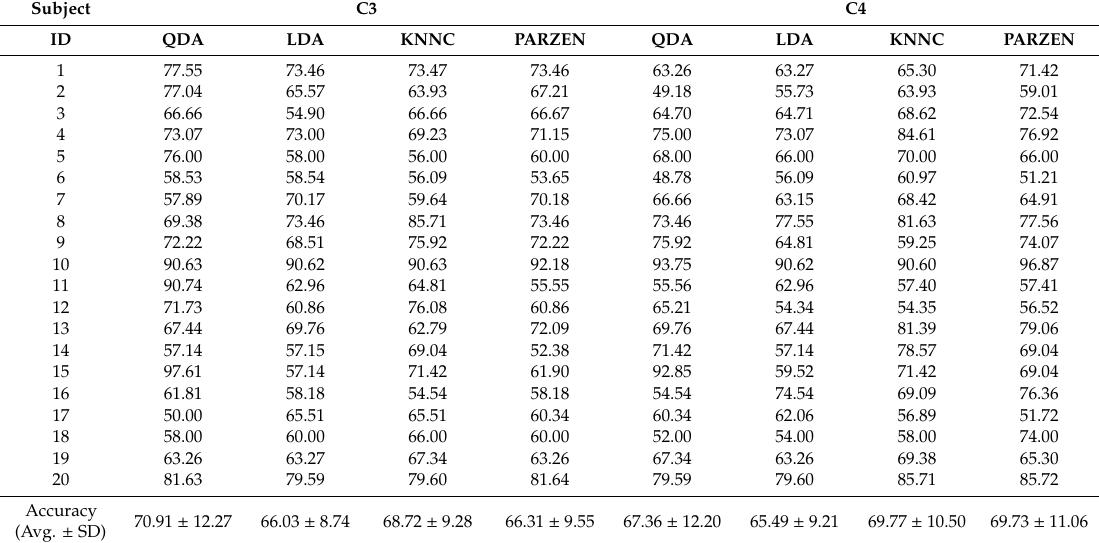
Table 3. Result of leave-one-out cross validation using the EEG frequency spectrum (1–50 Hz) as input in the machine learning approaches including QDA, LDA (parametric), KNNC and PARZEN (nonparametric). The performance of the classification system is compared in accuracy (%) during inter-subject and intra-subject variability at motor cortex (C3 and C4) of the